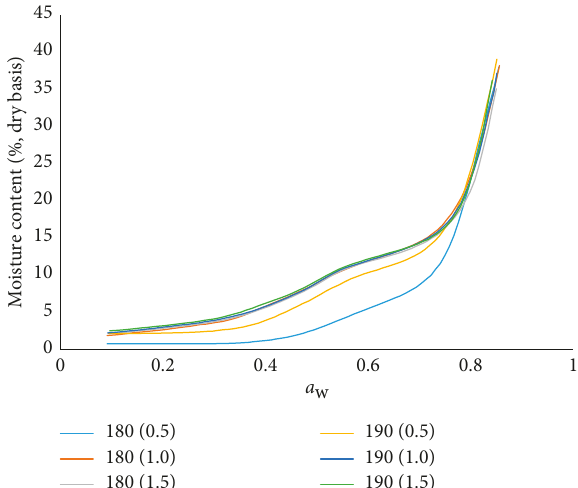
Figure 3: DDI comparative sorption isotherms of the agave FOS powders at different drying temperatures.